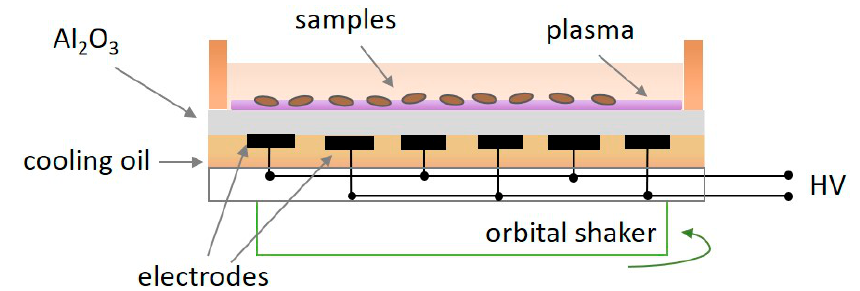
Figure 1. Configuration of the DCSBD plasma and experimental setup of the plasma treatment.